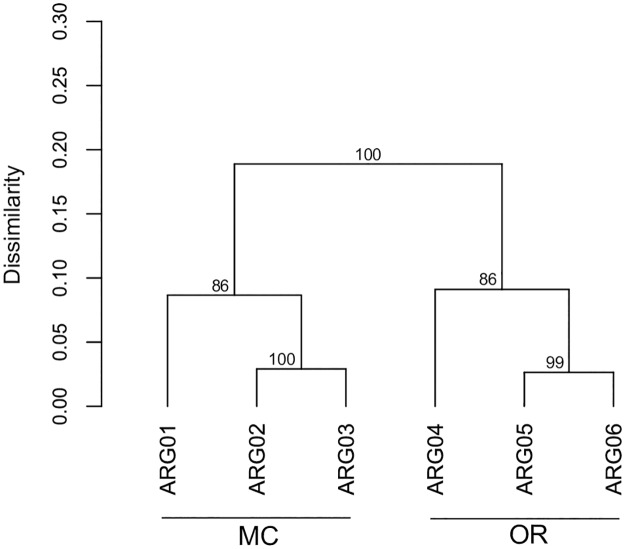
Cluster analysis of sediment metagenomes from Ushuaia Bay based on the abundance of sequences assigned to N-cycle biomarker genes.Bray-Curtis index was used as similarity measure. The grouping algorithm was average linkage. Bootstrap values were obtained from 1000 resamplings of the relative abundance matrix.